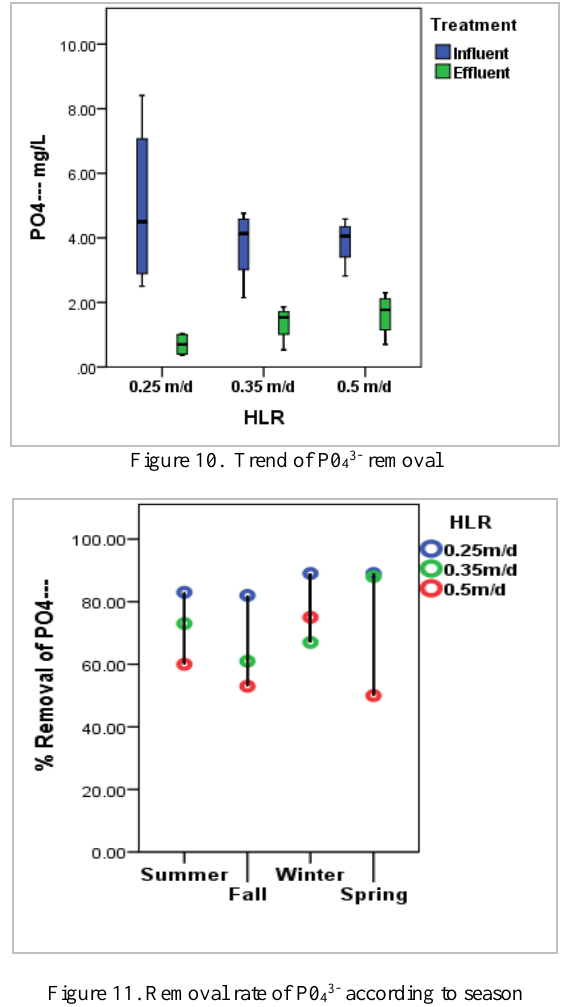
Figure 11. Removal rate of P0 43- according to